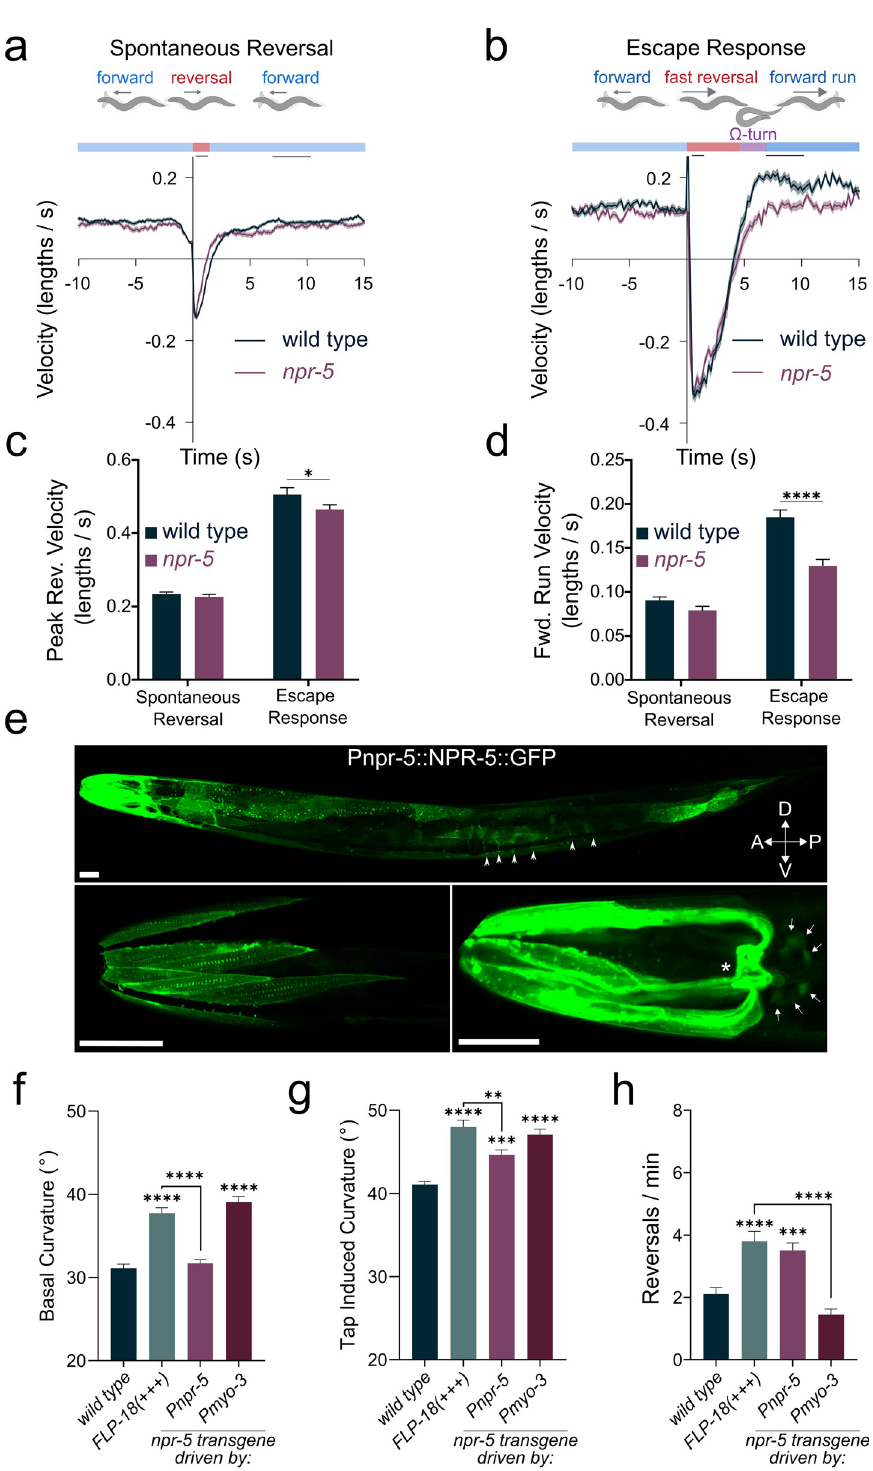
Fig 6. npr-5 mutants have defects in forward run speed, body bending and reversal frequency. (A-B) Schematic illustrating behavioral sequence (top) and velocity traces (bottom) from wild type and npr-5 mutants aligned to reversal events, backward locomotion is negative. Dark lines represent mean velocity and shaded region represents standard error. Reversals were spontaneous (A) or induced by a tap stimulus (B). (C) Peak reversal velocity during the first second following the tap stimulus. (D) Mean locomotion velocity during the forward run phase (t = 7-10s).